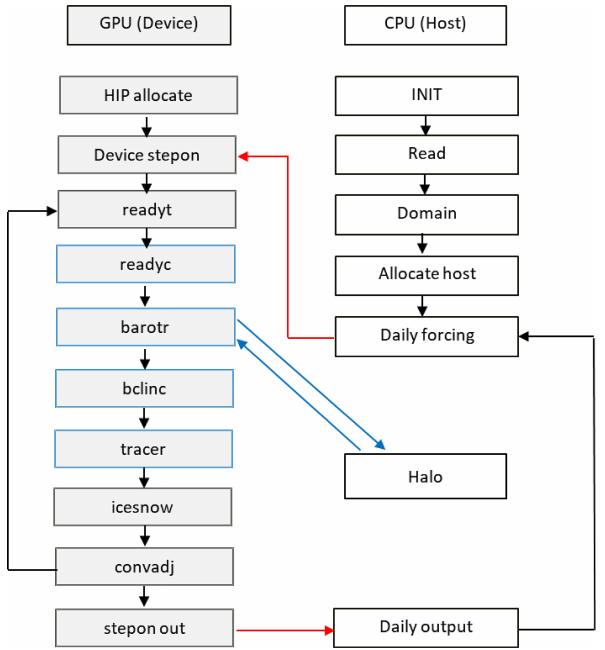
Figure 2. LICOM3 computation flowchart with a GPU (HIP de- vice). The red line indicates whole block data transfer between the host and GPU, while the blue line indicates transferring only lateral data of a block.